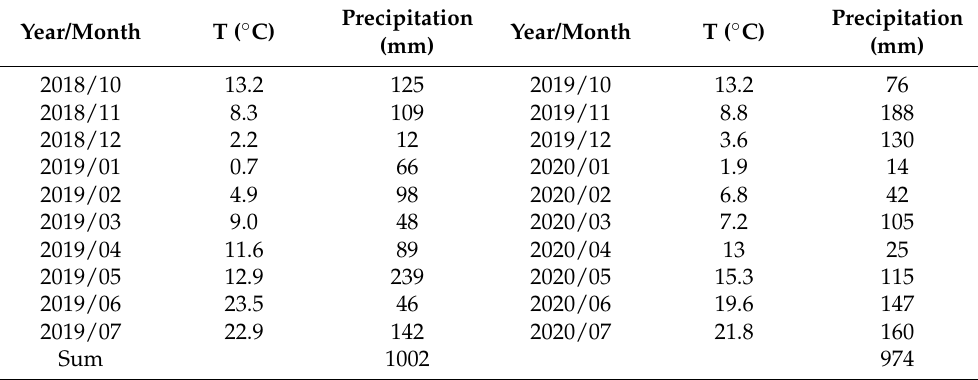
Table 11. Weather information for the crop season of 2018/2019 and 2019/2020 for Ljubljana,